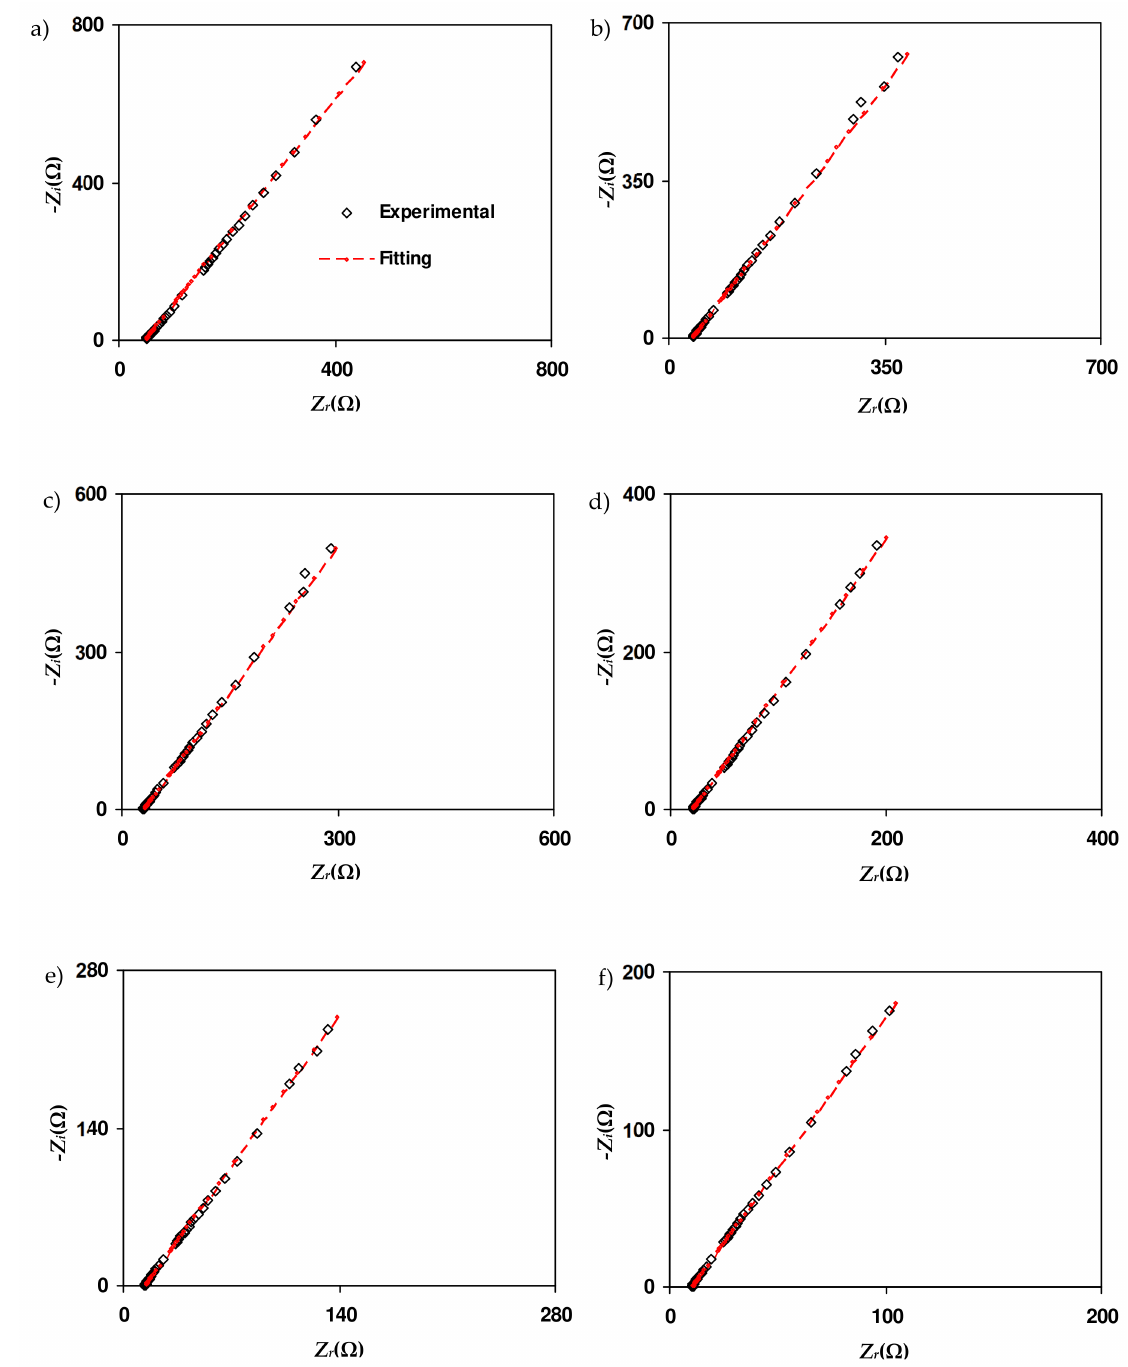
Figure 6. Nyquist plot for SL4 at ( a ) 298K, ( b ) 303K, ( c ) 313K, ( d ) 323K, ( e ) 333K and ( f ) 343K. The equivalent electrical circuit is used because it gives an easy and direct picture of the device. Figure 7a,b shows the corresponding circuit for the semicircle-spike and spike plots, respectively. Due to the electrolyte’s inhomogeneity, it was categorized as an “imperfect capacitor”, known as the constant-phase element (CPE). CPE is given as [46]